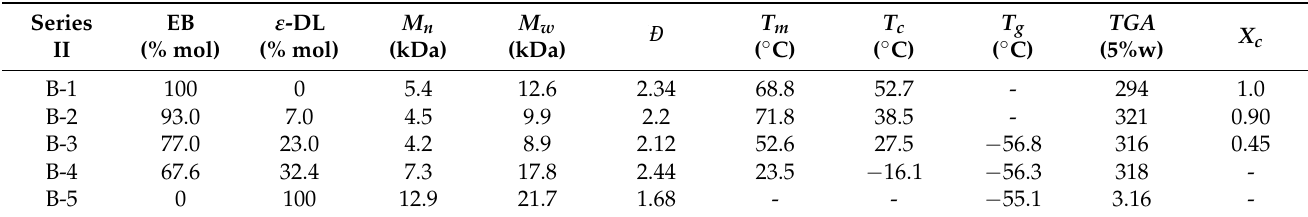
Table 2. Comonomer molar percentage, M n , M w , Table 3. Comonomer molar percentage, M n , M w , Ɖ , thermal properties and X c in Series III.